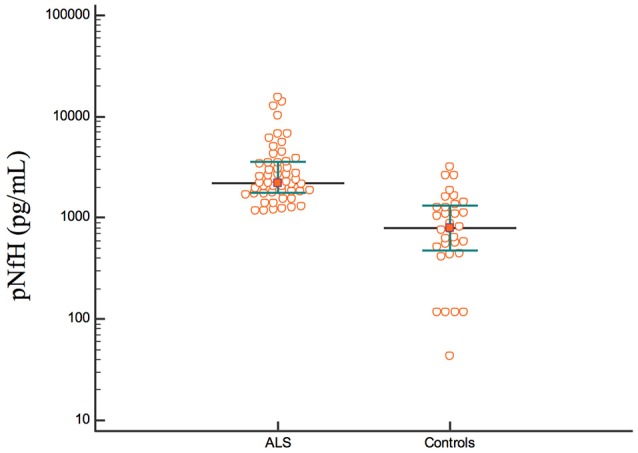
The concentrations of pNfH in the ALS and control group.